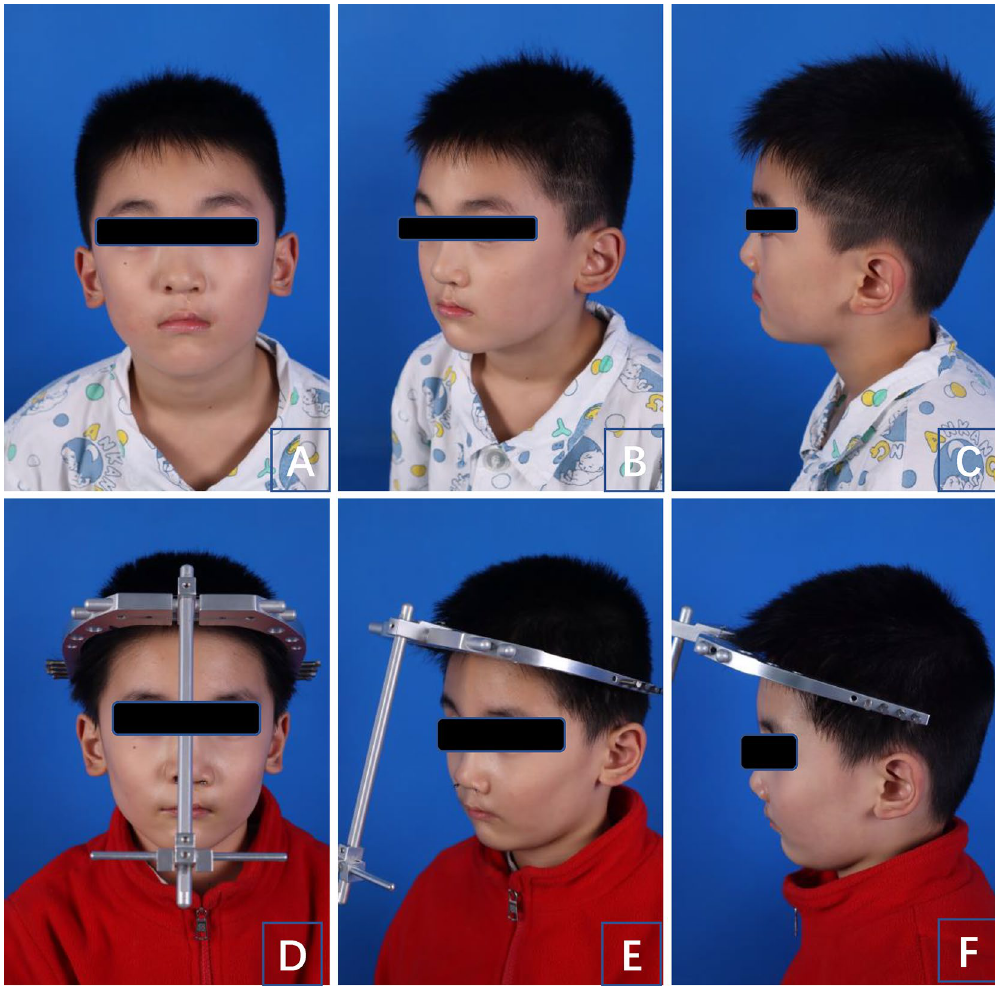
Figure 1. A patient were compared between preoperative and 2-months postoperative photographs (Preoperative: A (Front), B (Oblique), C (Lateral); Postoperative: D (Front), E (Oblique), F